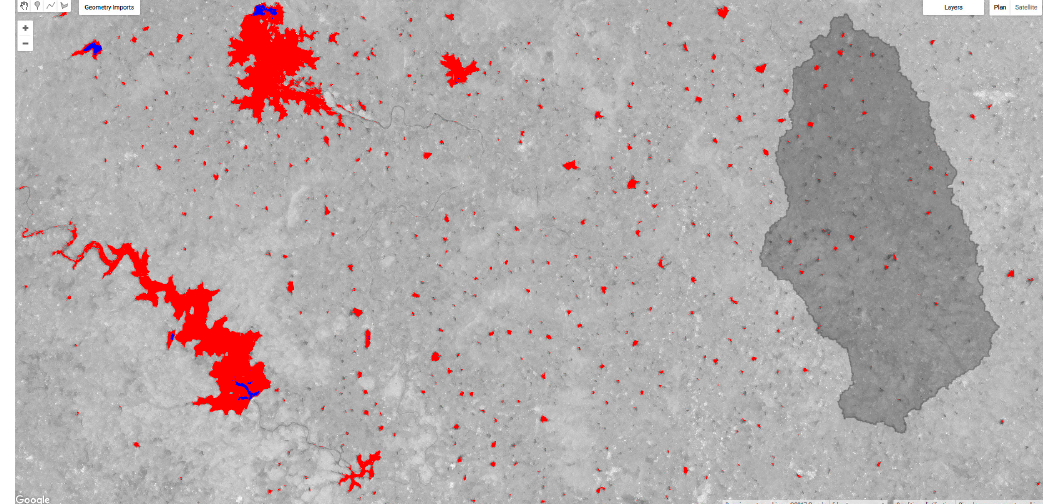
Figure 4. Surface water detection using a Sentinel-1 backscatter threshold (Google Earth Engine web platform) for March 2016 ( blue ) and October 2016 ( red ). The increase is explained by the heavy monsoon rainfall in September 2016. The background represents the VV backscatter of the October acquisition. The Kudaliar catchment is outlined by the darker gray area.